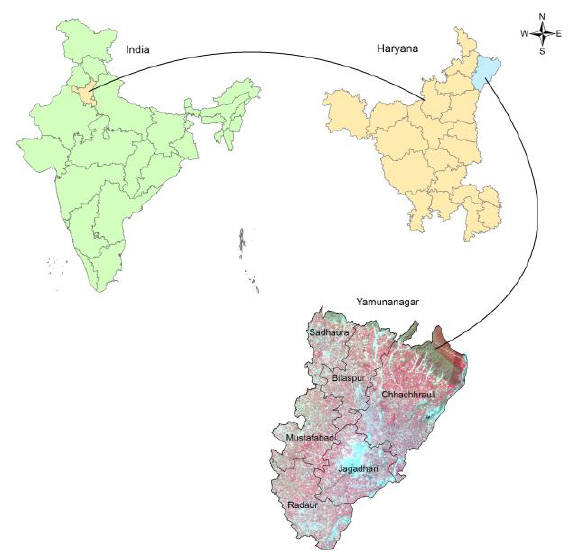
Figure 1. Location map of study area